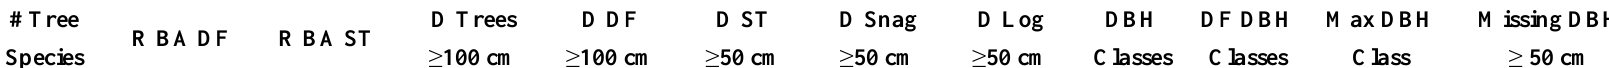
Table 3. Spearman correlation coefficients for the different variables attributed to old-growth stands. Variables represent Douglas-fir or shade tolerant species dominance, density of large trees, snags, and logs, and DBH distributions. See Table 2 for variables and abbreviations.